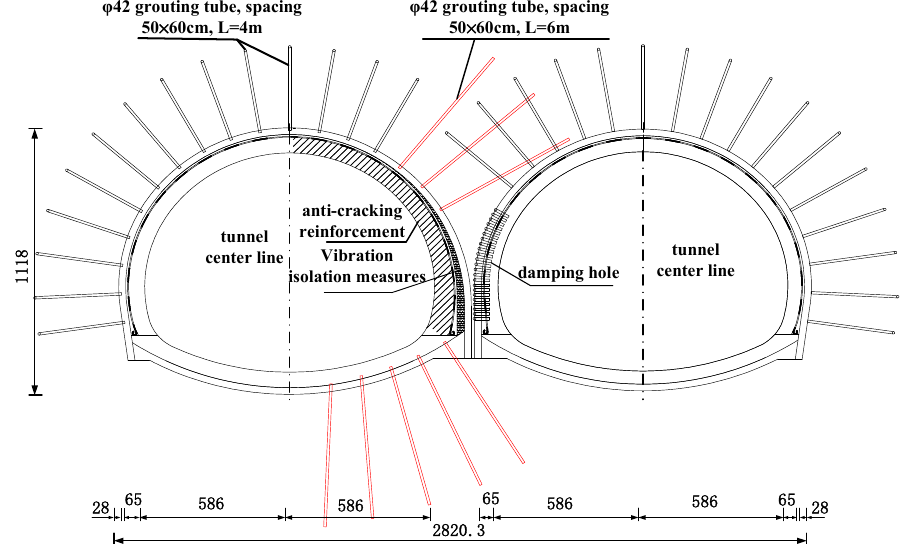
Figure 4. Cross-sectional parameters (unit: cm).